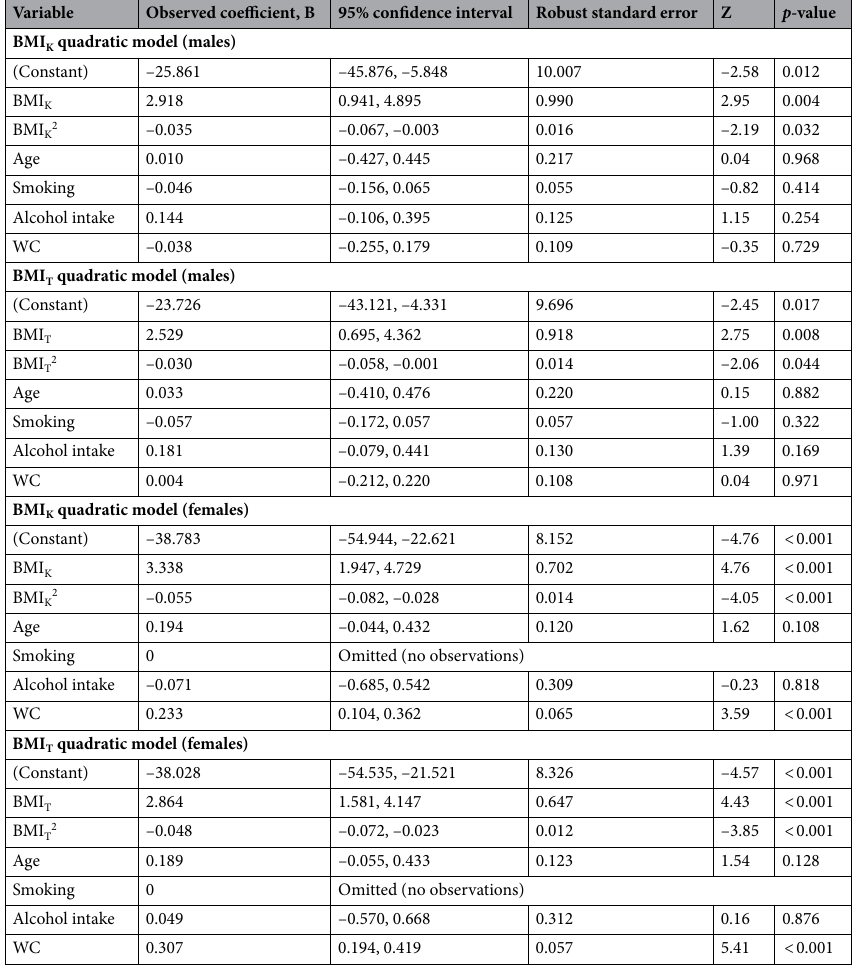
Table 5. Summary of the robust polynomial regression analysis of the BMI K and BMI T quadratic models. %BF body fat percentage, BMI T BMI calculated using the proposed modified (Trefethen) formula, BMI K BMI calculated using the Quetelet index popularized by keys, WC waist